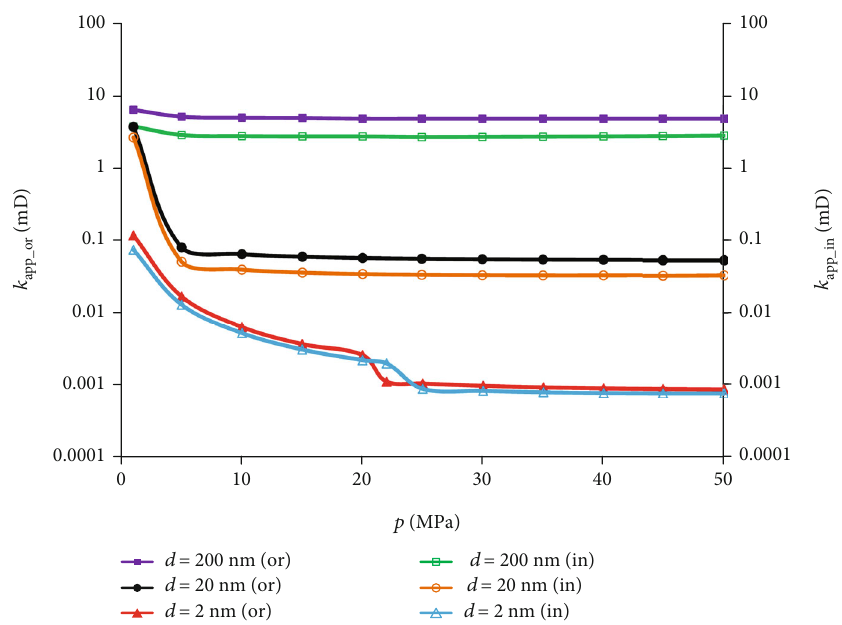
Figure 4: AGP comparison between organic and inorganic pores with di ff erent sizes under reservoir conditions.